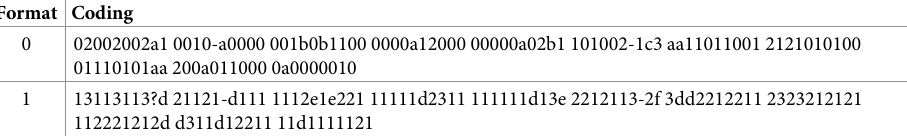
Table 3. Character-coding for Cryptoxenodon metamorphus sp.